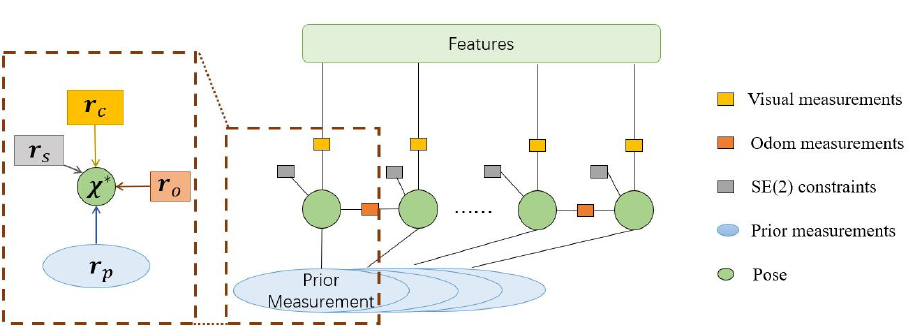
Figure 5. The factor graph of sliding window variable